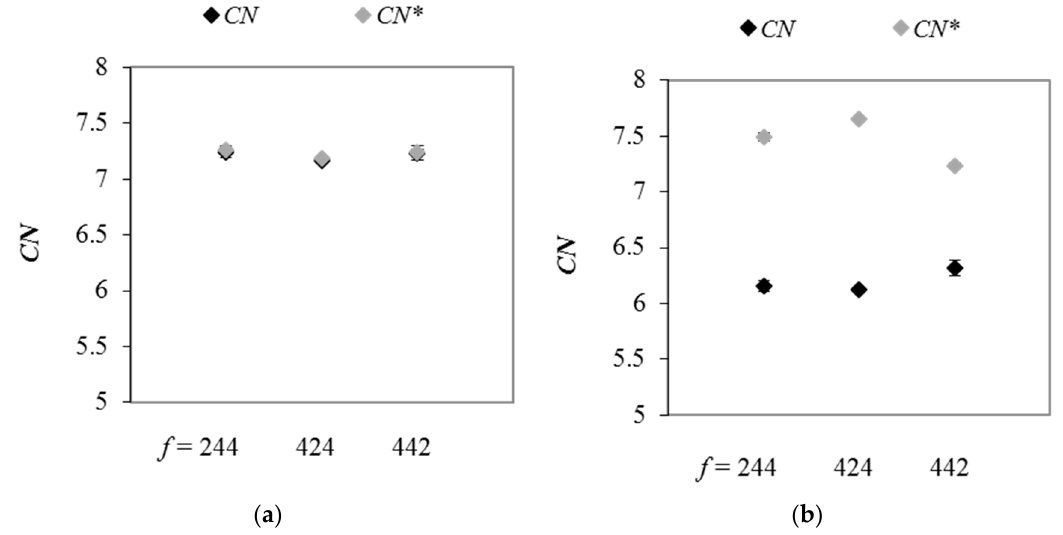
Figure 12. The average coordination numbers and mechanical coordination numbers in mixtures with g =1.25 ( a ) and g = 3.75 ( b ) and various f values, under vertical load of 100 kPa.